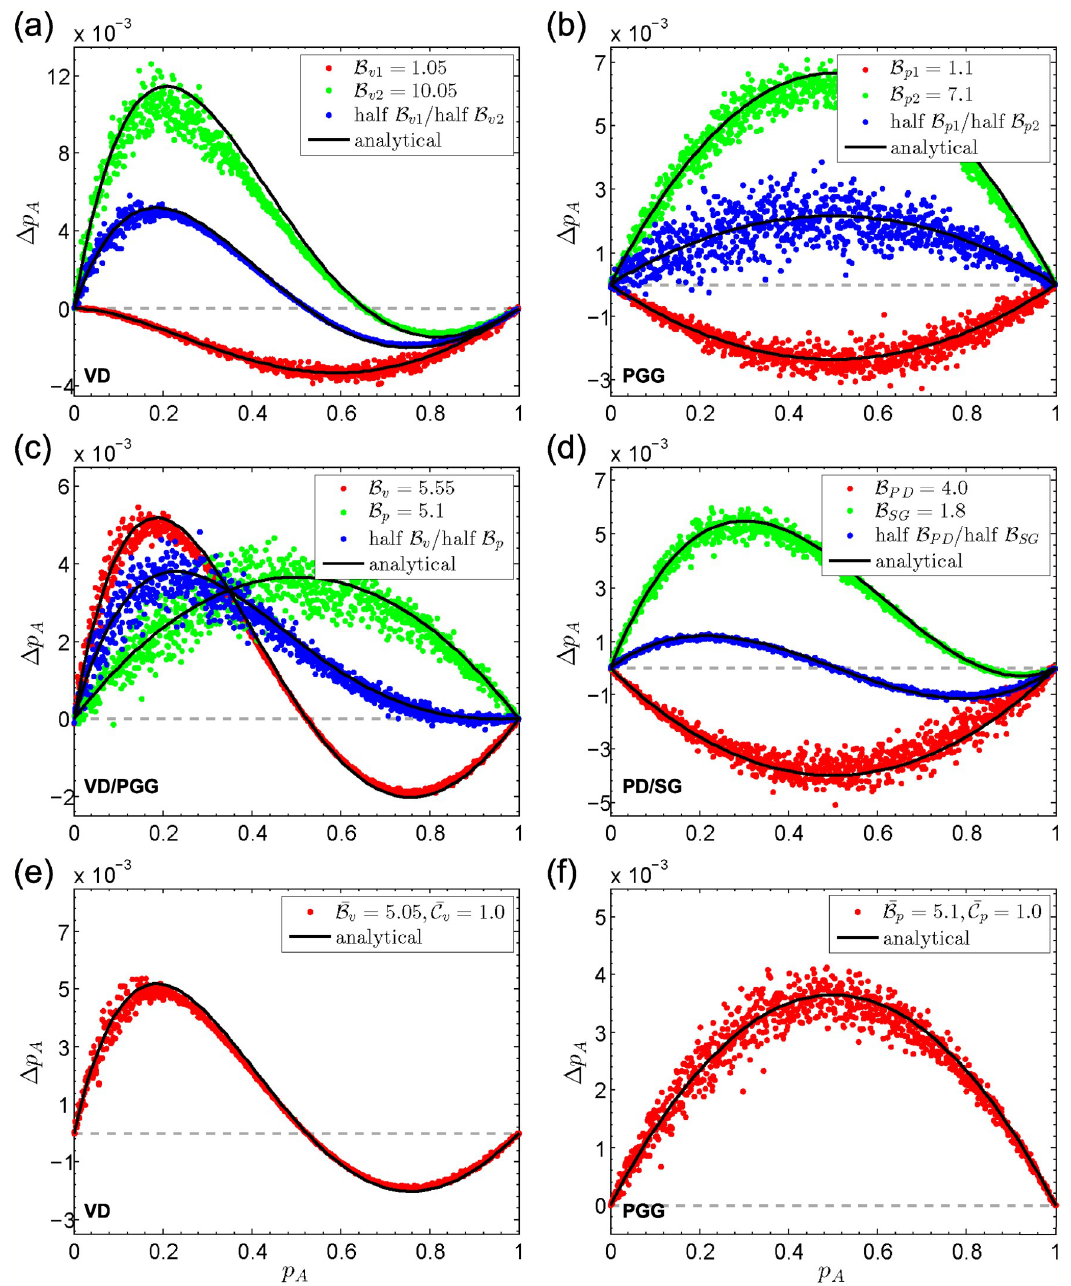
Fig 2. Average change ( Δ p A ) in the frequency of A-players ( p A ), in volunteer’s dilemmas (VD), public goods games (PGG), diverse multiplayer games (VD/PGG), and diverse two-player games (PD/SG). The population structure is a random regular graph with N = 1000, n = 2, and g 1 = g 2 = 3. In (a-c), the cost to cooperate is fixed to 1 and benefits are shown in the legend of each . Under each SG , the total cost for panel. In (d), under PD , a cooperator bears a cost 1 to provide its opponent with a benefit B PD cooperators is 1 and the benefit for each player is B . Three cases are investigated in each panel of (a-d). For example, in (a), benefits SG in all multiplayer interactions are B ¼ 1 : 05 (red dots), B ¼ 10 : 05 (green dots), or designated at equal proportions (blue dots). In v 1 v 2 (ef), both benefits and costs in each interaction are sampled according to a Gaussian distribution, with mean � B ¼ 5 : 05 , variance 1.5 v ¼ 1 : 0 , variance 0.25 for costs (e), mean � B ¼ 5 : 1 and variance 1.5 for benefits and mean � C ¼ 1 : 0 and for benefits and mean � C v p p variance 0.25 for costs (f). Dots represent the simulation data and lines are analytical predictions based on unified interactions with average payoffs (see S1 File, Section 6 for simulation details).